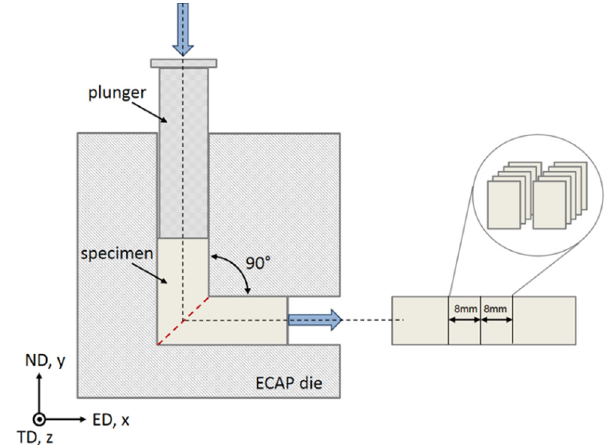
Figure 1. Schematic diagram of the reference coordinate system and sample taking according to the die geometry. ED, ND, and TD denote extrusion, normal, and transverse direction, respectively.